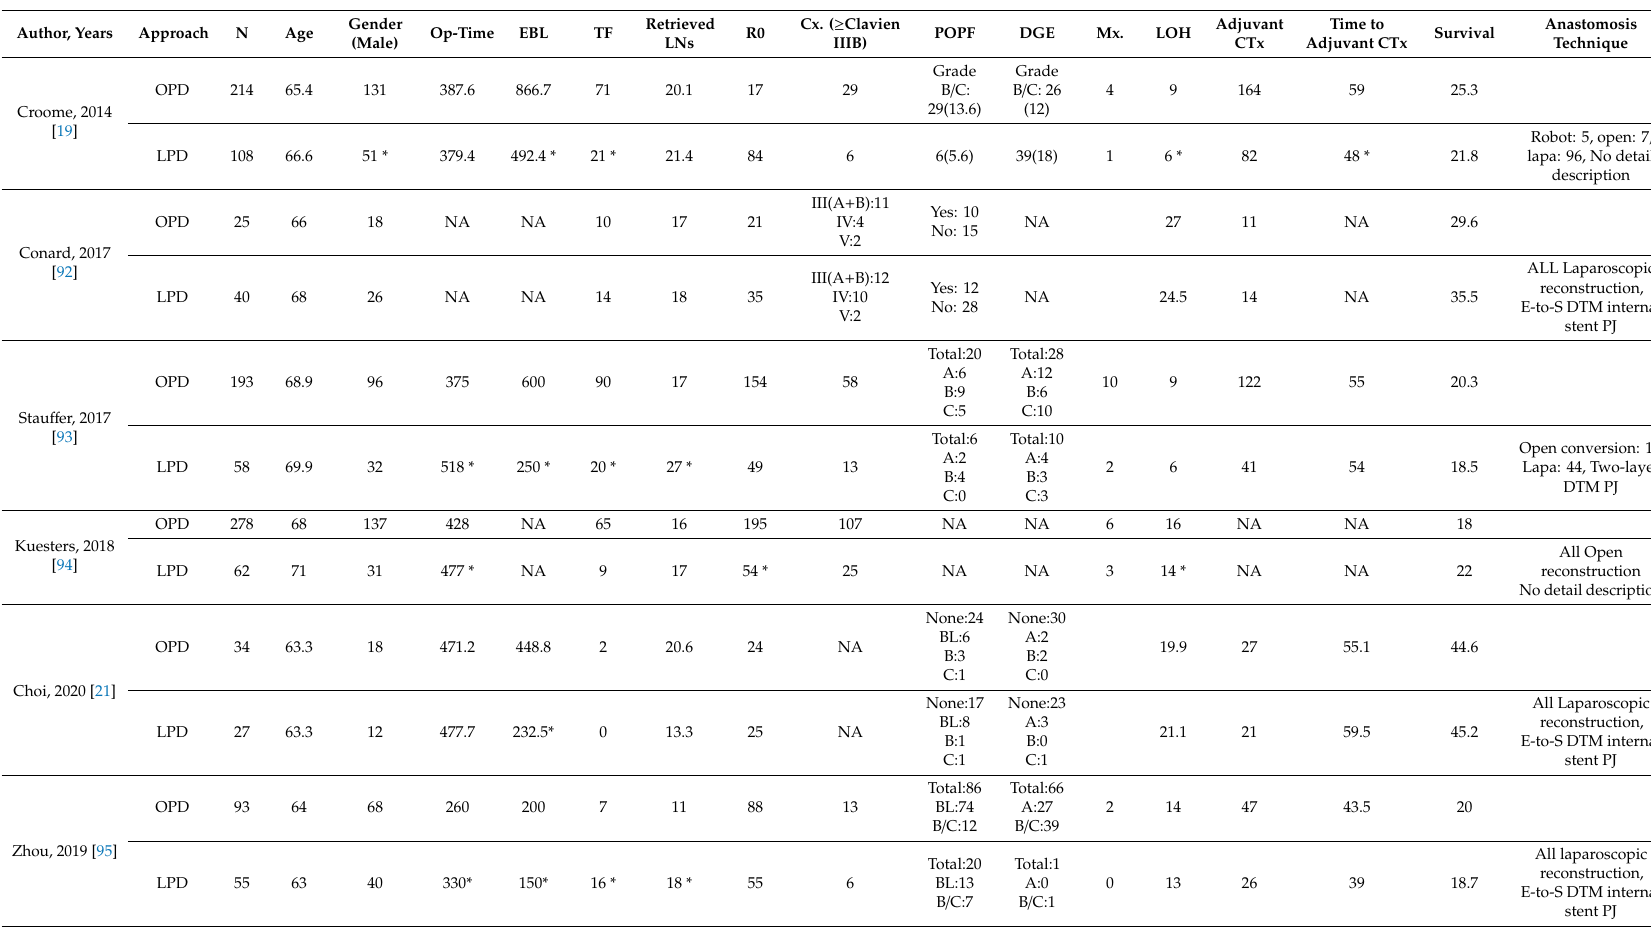
Table 6. Summarized recent articles investigating oncologic outcomes comparing between LPD and open pancreaticoduodenectomy (OPD) for pancreatic